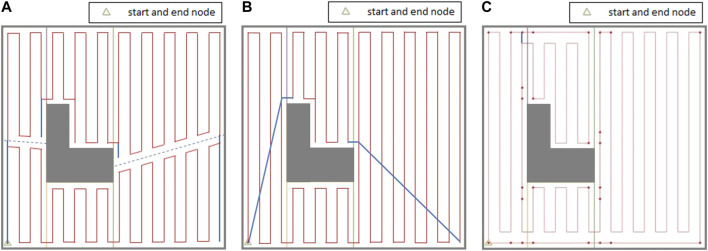
The complete coverage path generated by: (A) the CPP technique proposed in (Xu et al., 2014), (B) the CPP technique proposed in (Tung and Liu, 2019), and (C) the proposed CPP technique based on the graph representation of environment. The solid red lines represent the generated path, and the solid blue lines represent the overlapped parts of the path. The dashed blue lines show the common boundaries of the divided cells.